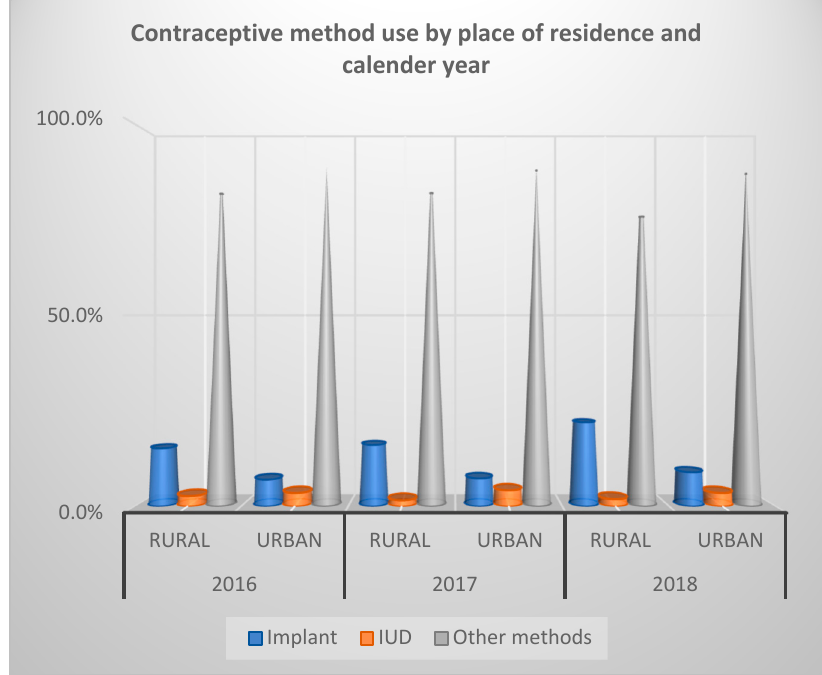
Figure 1. Overall contraceptive utilization rate by place of residence and year of PMA survey among women 15-49 years in Nigeria.